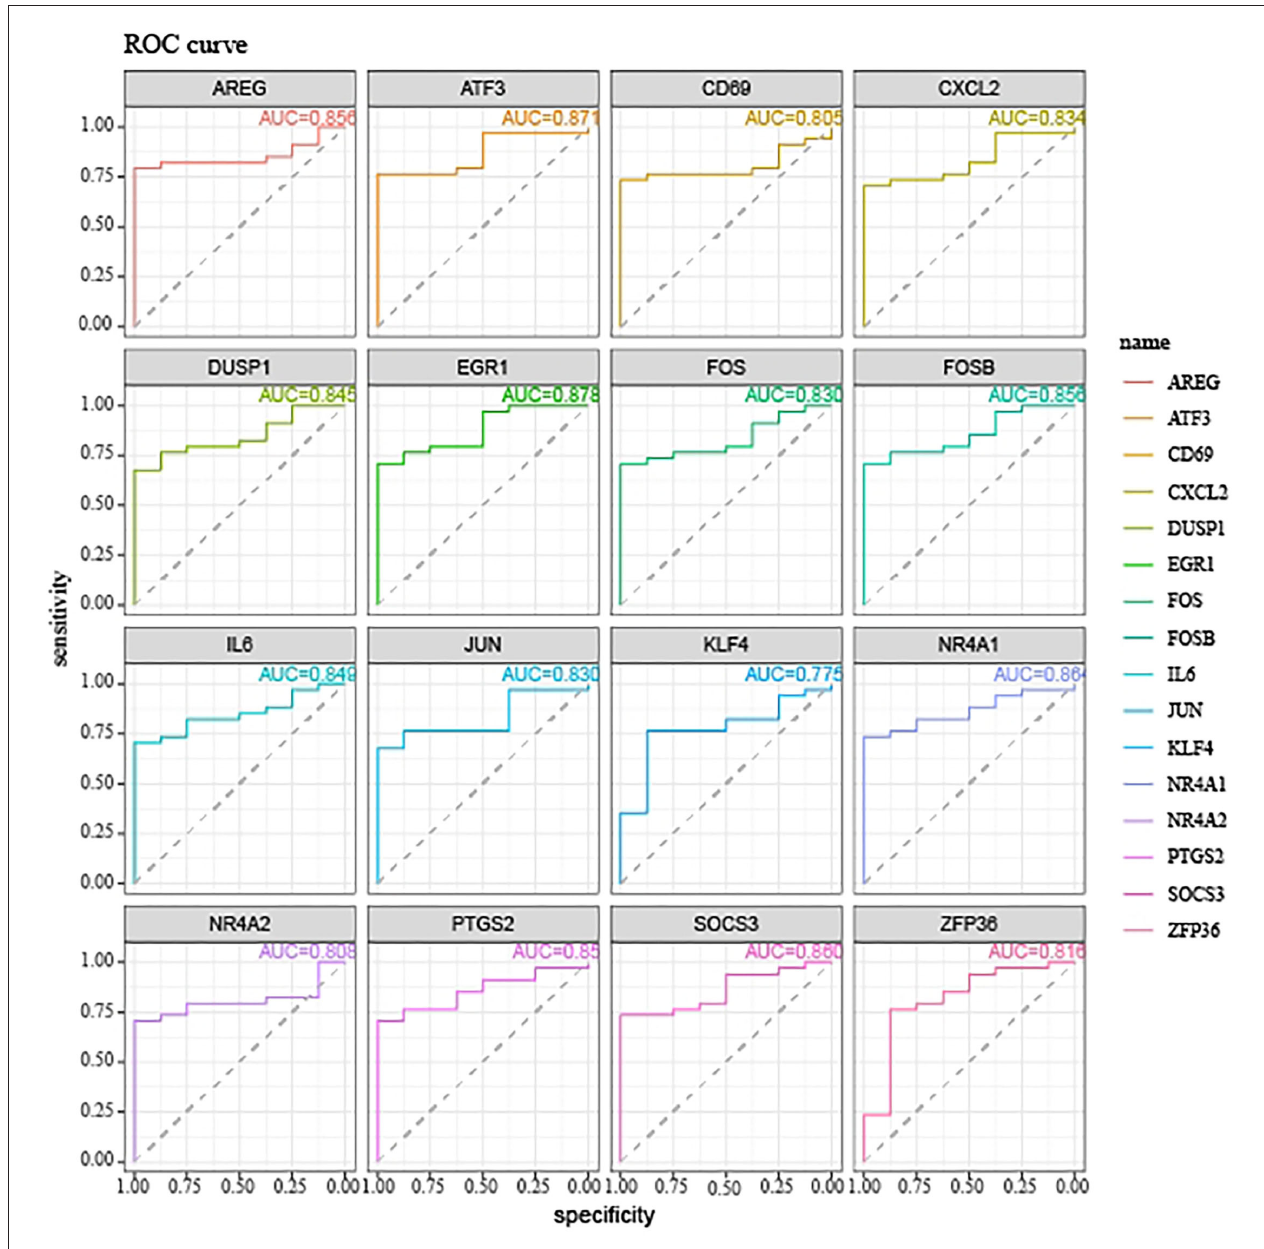
FIGURE 3 | ROC curves showing the diagnostic value of hypoxia-related DEGs in the PPI network.